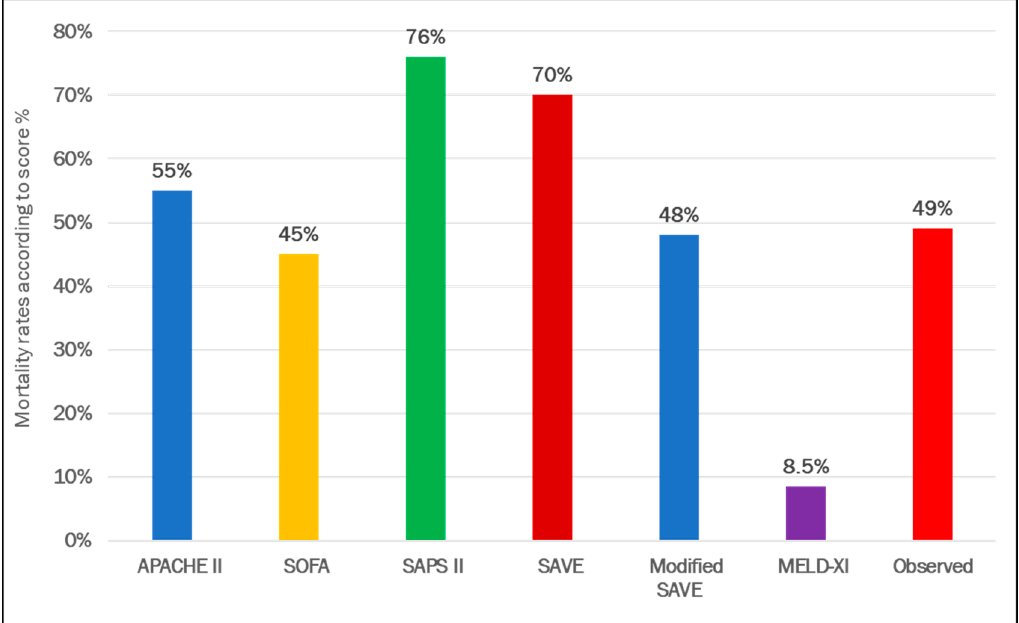
Figure 2. Comparison of predicted and observed mortality rates in patients supported with veno-arterial extracorporeal membrane oxygenation.